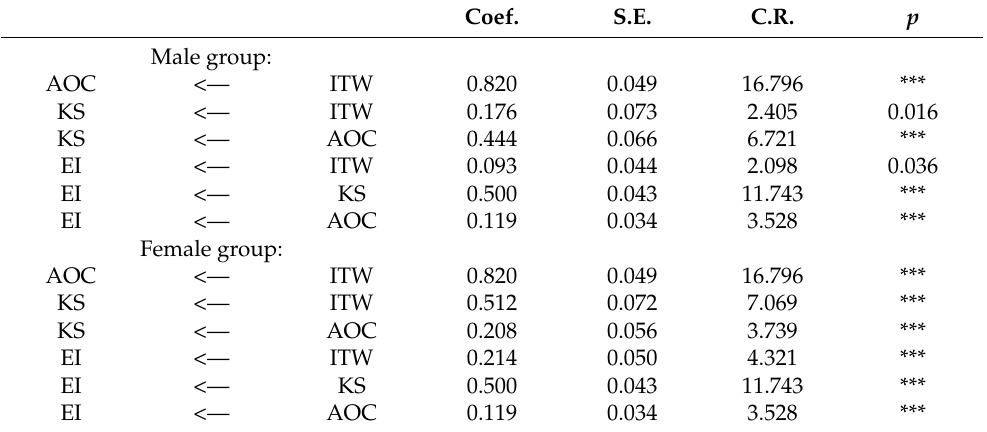
Table 7. Structural relationships with the same weight restrictions between gender groups.